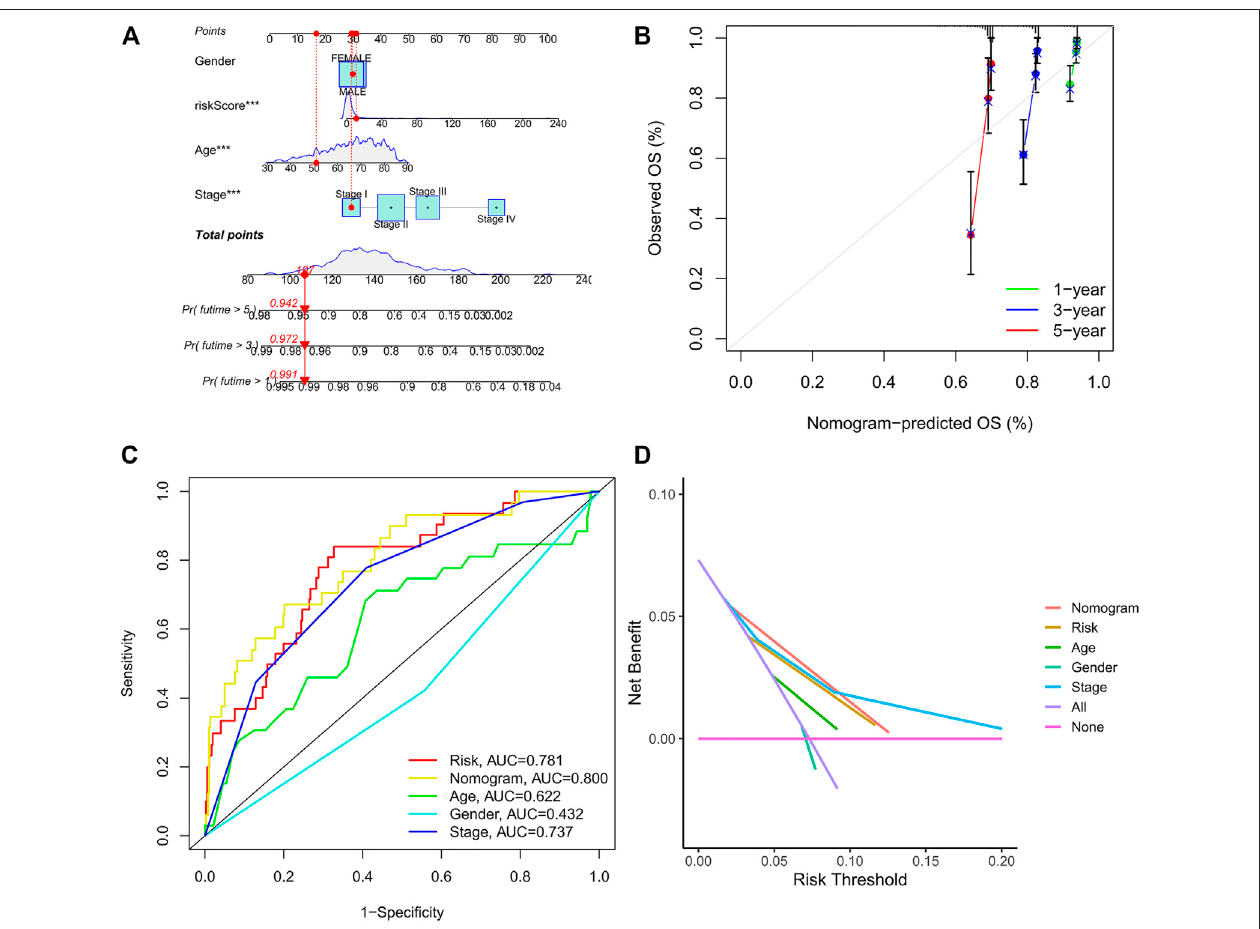
FIGURE 7 | Construction of the prognostic nomogram. (A) The nomogram of 1-, 3-, and 5-year overall survival based on risk score, age, gender, and TNM stage. (B) Calibrationplotofnomogramforpredictingprobabilitiesof1-,3-,and5-yearsurvivalofpatientswithCRC. (C) AcomparisonofROCcurvesshowedthesuperiorityof the nomogram and IRG signature. (D) Decision curve analysis of nomogram, IRG signature, and other clinicopathological features.